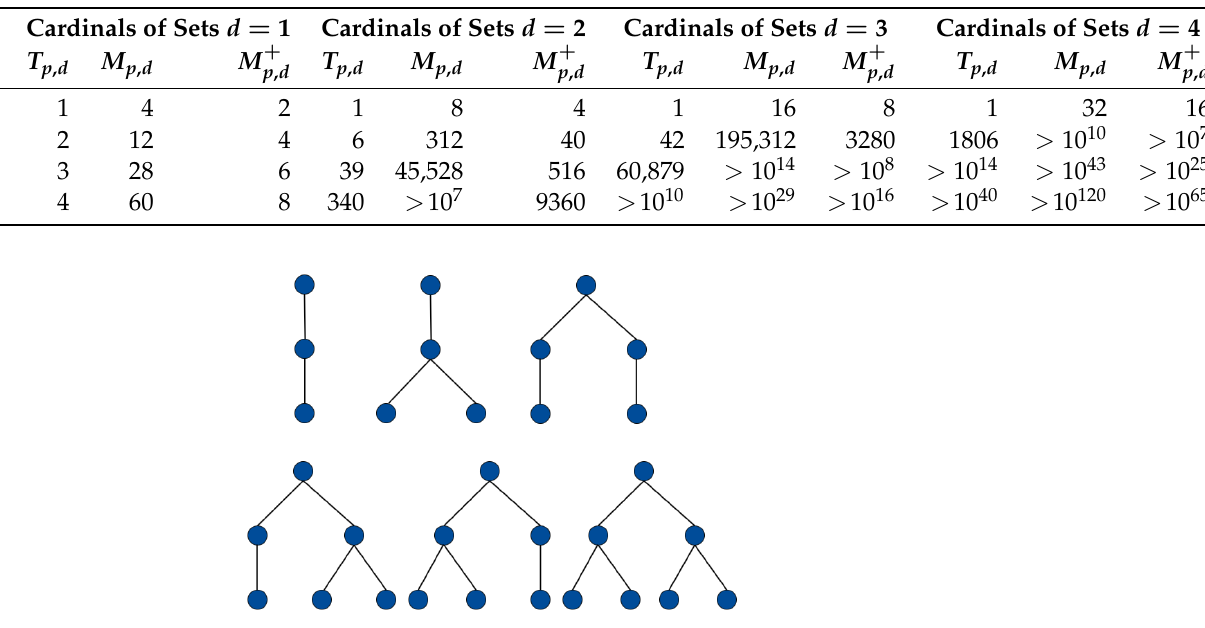
Figure 2. There are 6 trees in T 2,2 , the set of rooted trees with depth 2 and fanout